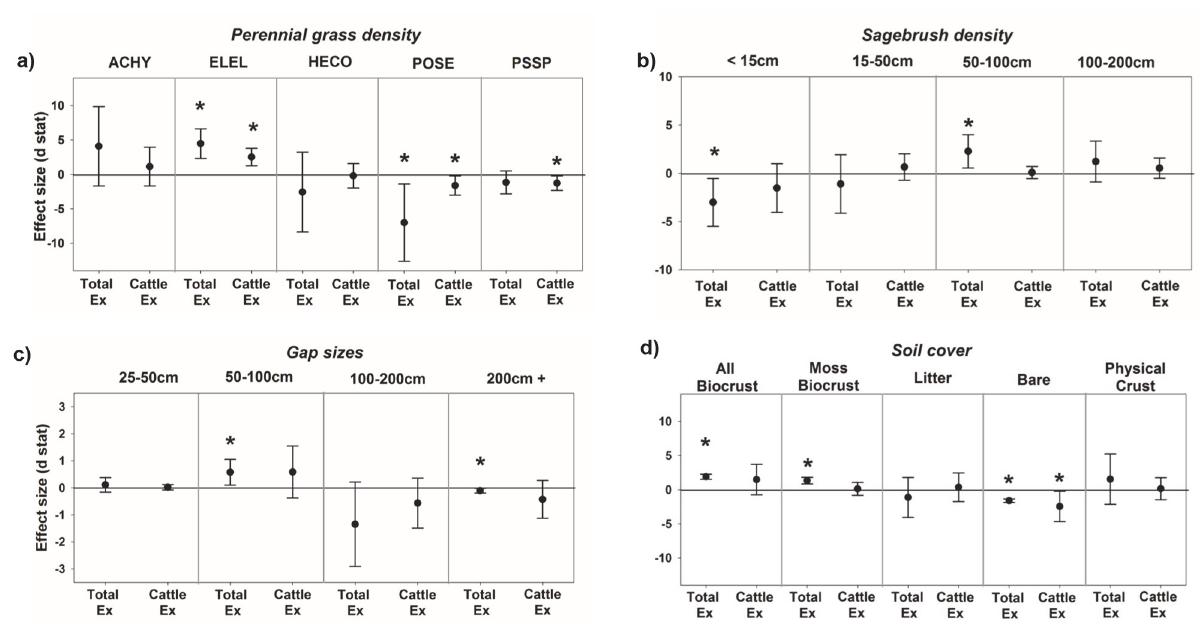
Fig 4. Effect size analyses. Effect size analyses of (a) perennial grass ( Achnatherum hymenoides [ACHY], Elymus elymoides [ELEL], Hesperostipa comata [HECO], Poa secunda [POSE], Pseudoroegneria spicata [PSSP]) density, (b) sagebrush ( A. tridentata ssp. wyomingensis ) density, (c) inter-plant gap size, and (d) soil cover across herbivore treatments. “ Total Ex ” denotes exclusion of all large herbivores, and “ Cattle Ex ” denotes exclusion of only cattle (but not wild herbivores). If symbol is above the zero line, then magnitude of response is greater in the treatment exclosure than in the control. If symbol is below the zero line, then response is less than in the control. Error bars show 90% CI. If error bars do not equal or cross zero line, then difference is considered significant.